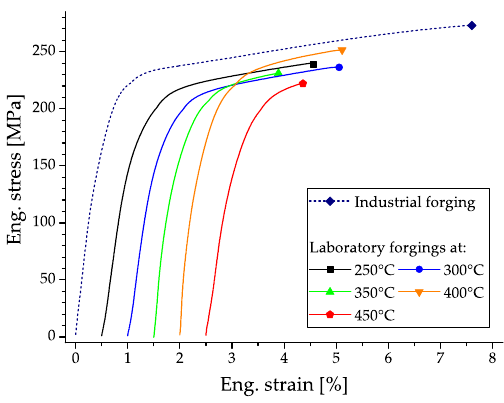
Fig. 8 Representative measurements from tensile testing of forged parts in T6 temper. For an improved overview the stress-strain curves are shifted by 0.5 % eng. strain and fracture is marked by symbols